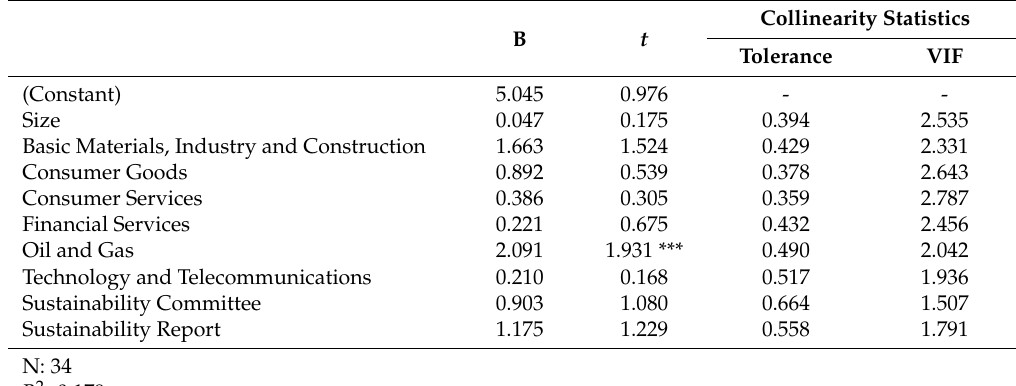
Table 9. Environmental Matters Index as Dependent